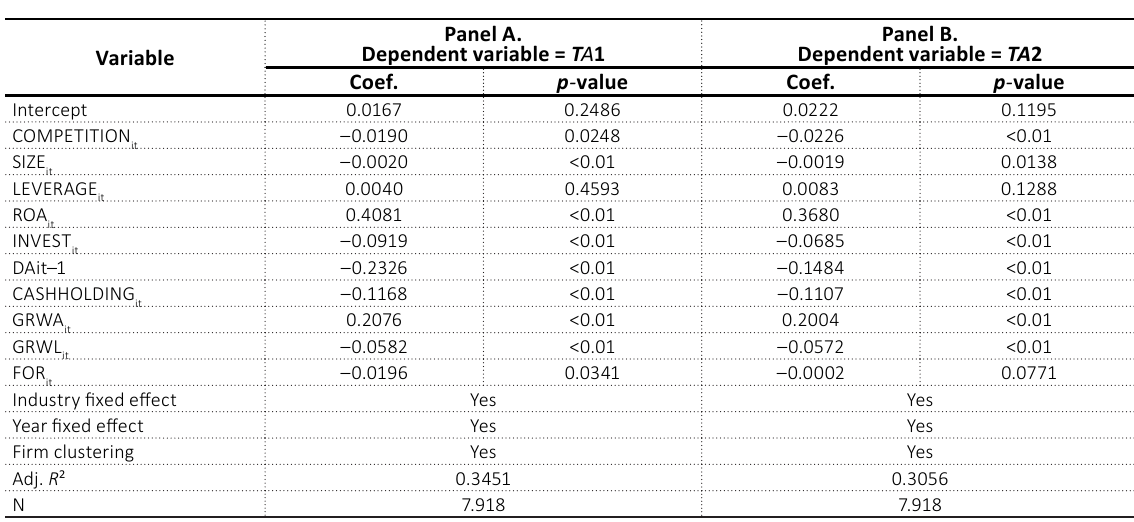
Table 4. Product market competition and tax avoidance activities